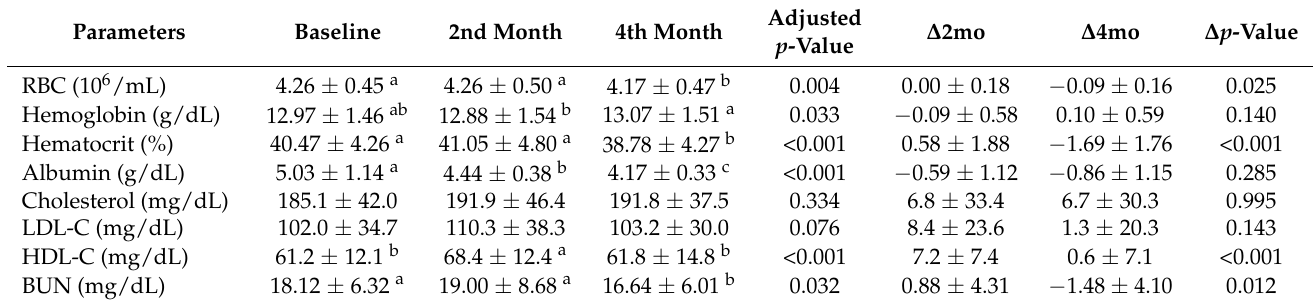
Table 2. Complete blood counts and serum biochemical parameters.